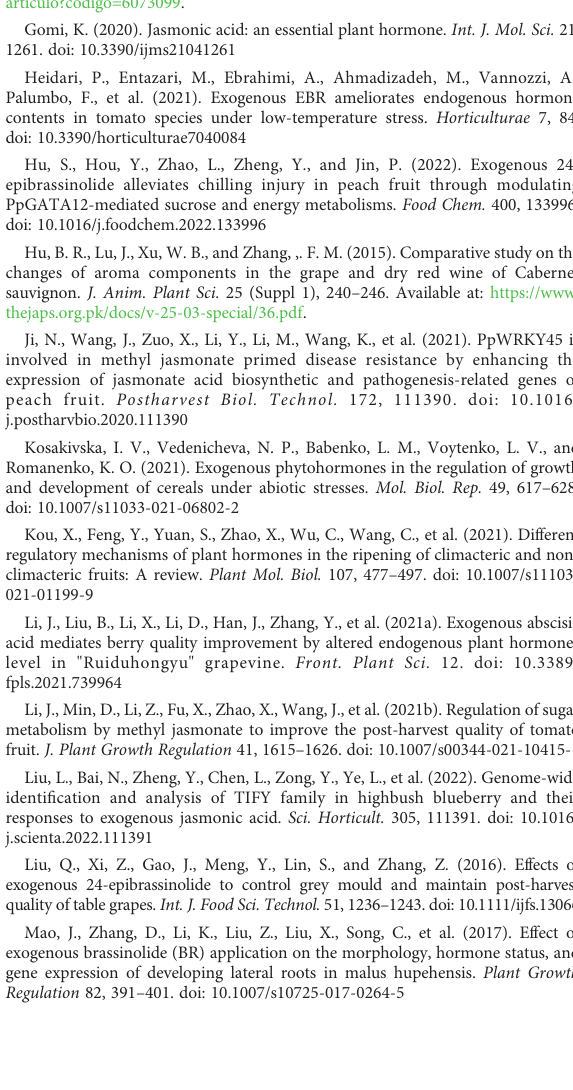
SUPPLEMENTARY FIGURE 4 The correlation analysis among different endogenous phytohormones and berry quality-related parameters. Total of 12 phytohormones were represented in the vertical row, 3 kinds of appearance parameters, 11 kinds of biochemical properties, 6 kindsof antioxidant-related substances and 10 kinds of fatty acids were represented in the horizontal row. The strength of the relational degree was indicated by bubbles size, in which a positive correlation was represented by red color and a negative correlation was represented by blue color. SUPPLEMENTARY TABLE 1 Detection and quanti fi cation limits of phytohormones by